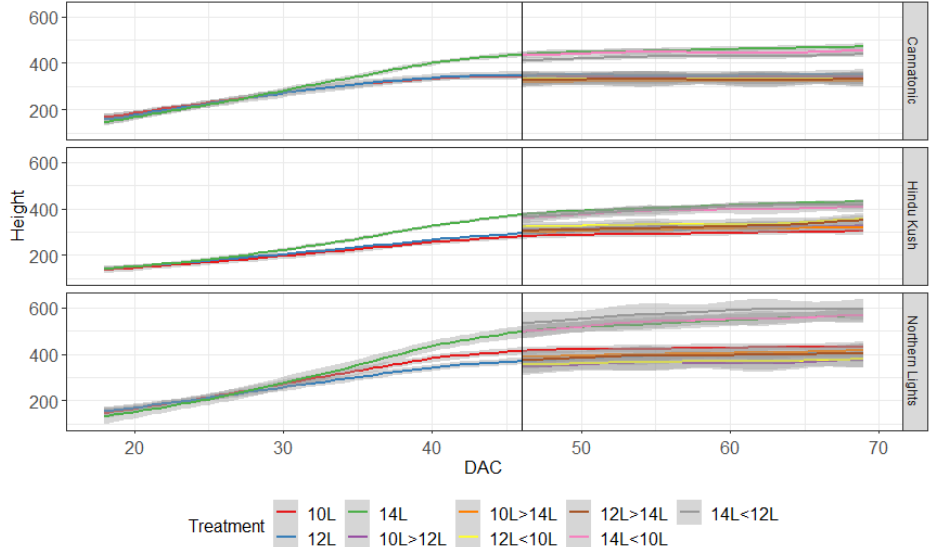
Figure 1. Plant height (mm) for the 9 treatments over time. The graph starts when plants entered the flowering treatments. The black line shows the point at which plants moved to their second treatment. DAC 46 N = 15, after DAC 46 N = 4 − 5.